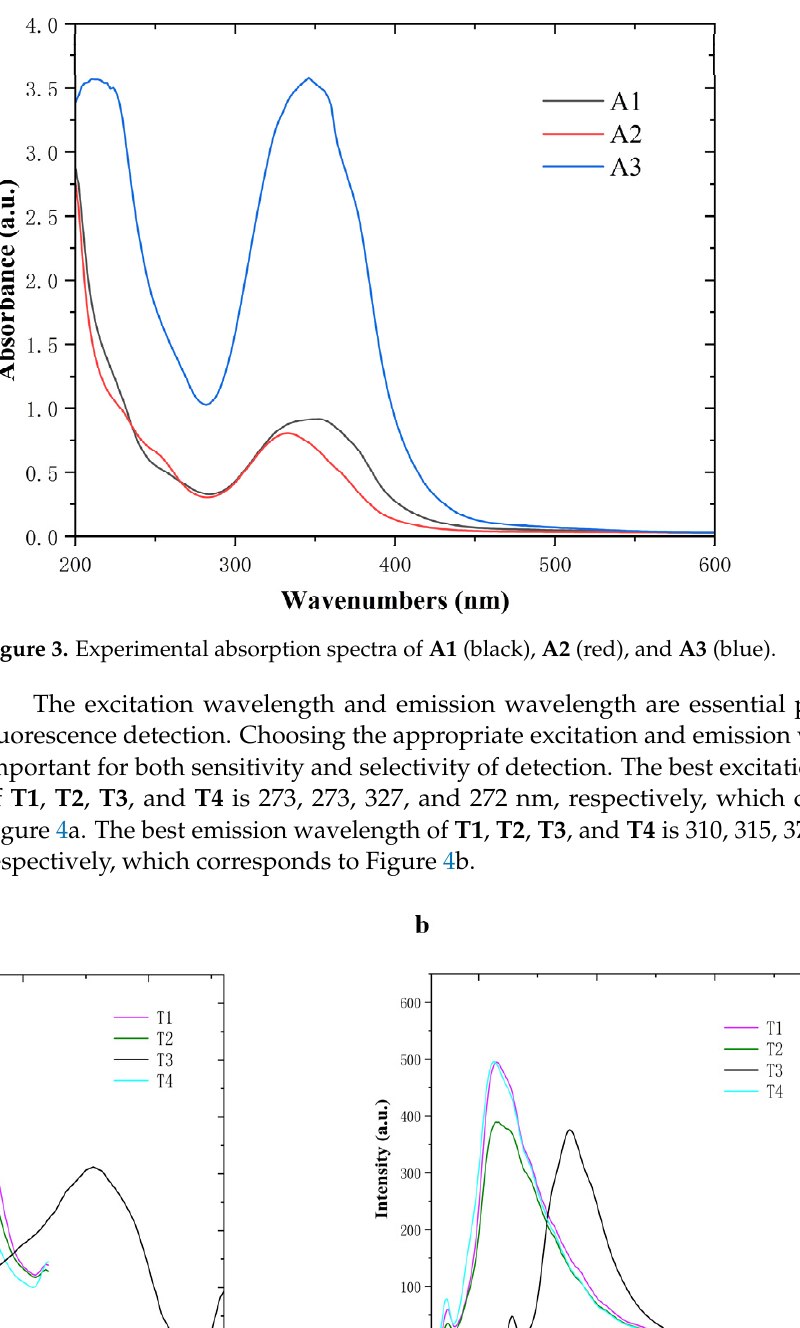
Figure 2. Synthesis routes of the probes T1 – T4 .